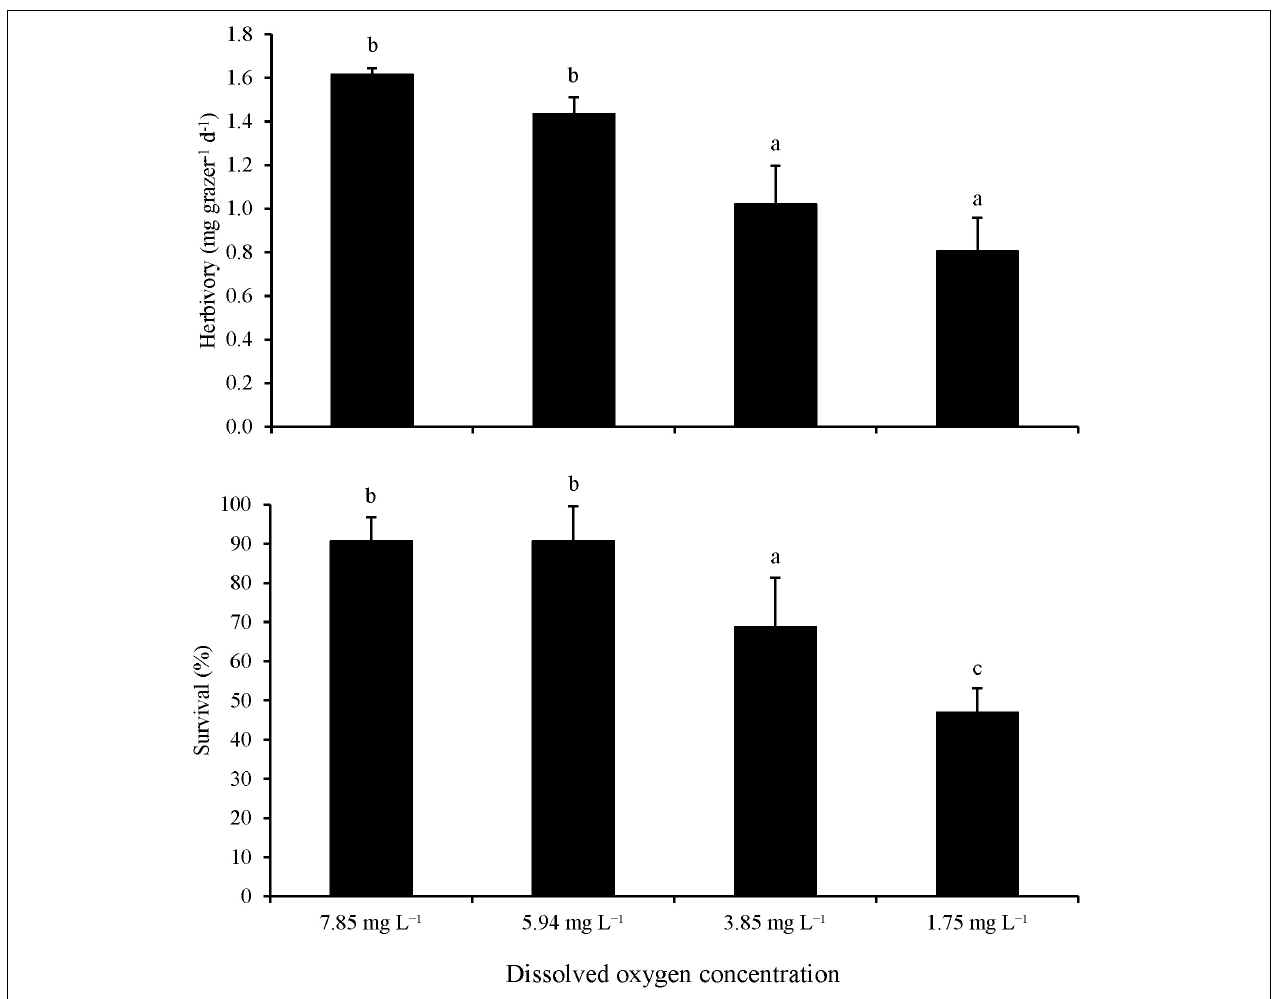
FIGURE 5 | Herbivory rates and survival of L. vincta initially starved and allowed to graze on U . rigida under ambient (7.85 mg L − 1 ), medium (5.94 mg L − 1 ), low (3.85 mg L − 1 ), and very low (1.75 mg L − 1 ) DO concentrations for 72 h (Experiment 5; Table 2 ). Statistical analyses: One-way ANOVA and post hoc Tukey Honest Significant Difference tests performed; significant differences between treatments represent p -values less than